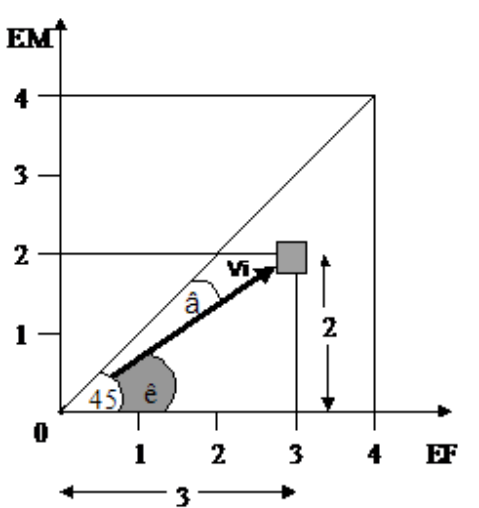
Figure 4 . Dislocation of vector Vi (Angle a) in relation to the